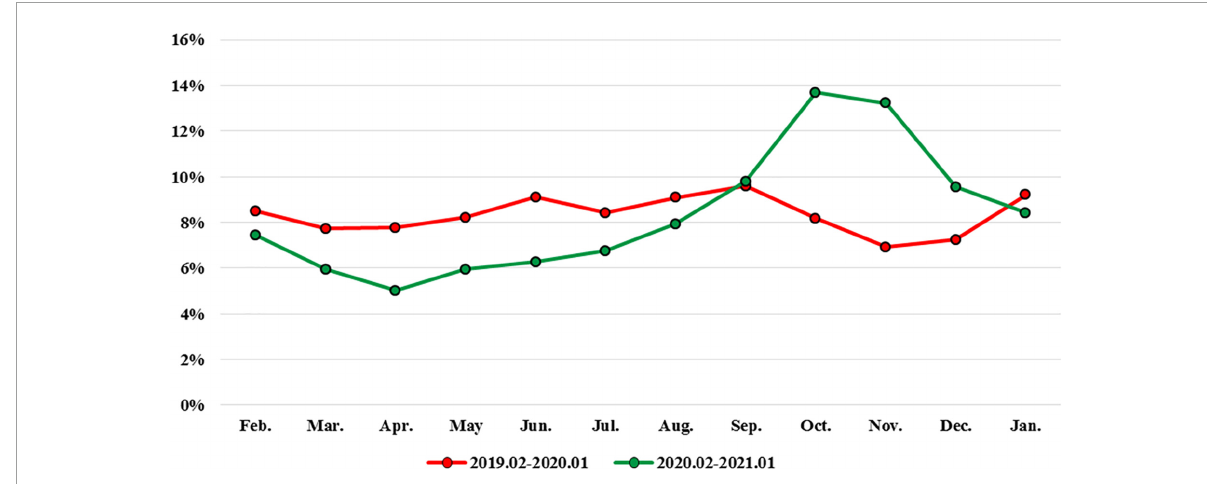
FIGURE1 Percent change in pediatric emergency department volume vs. new Taiwan SARS-CoV-2